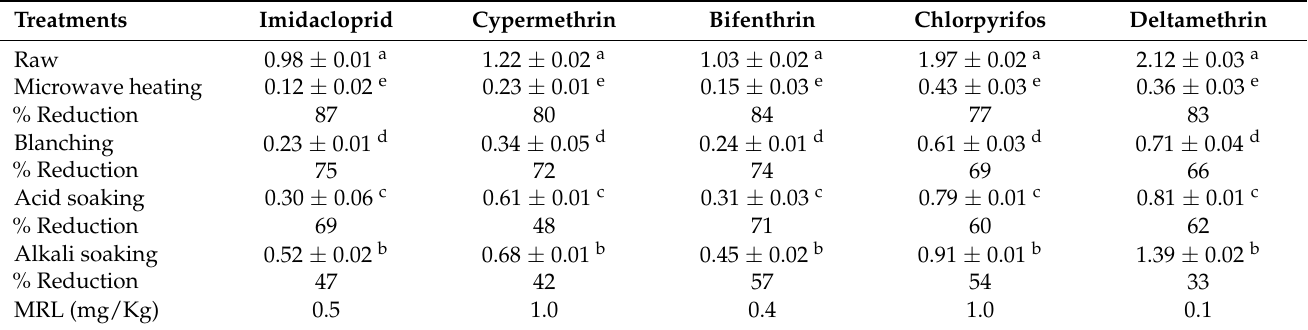
Table 5. Pesticide residues in raw and processed cabbage powders